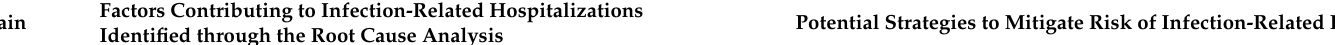
Table 4. Factors contributing to infection-related hospitalizations identified through the root cause analysis and potential strategies to mitigate the risk of hospitalization that were identified by panel